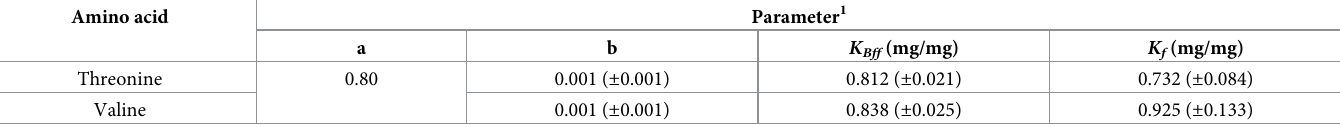
Table 5. Parameter estimates for describing each amino acid deposition in growing broilers as a function of intake of amino acid above maintenance (mg/bird/day) and age of broiler chickens according to multivariate model. Standard errors are given in a parenthesis. Amino acid